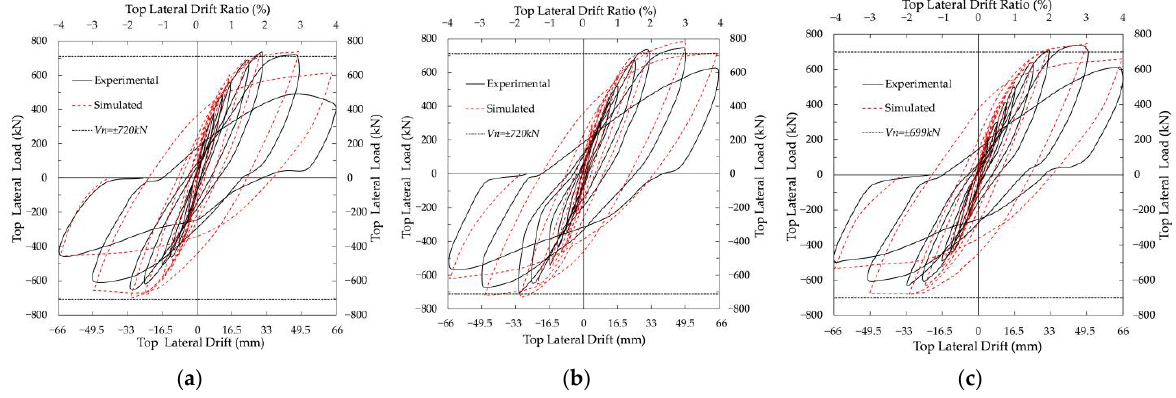
Figure 27. Comparison of skeleton curves of three numerical models. ( a ) CS-1; ( b ) CS-2; ( c ) CS-3.